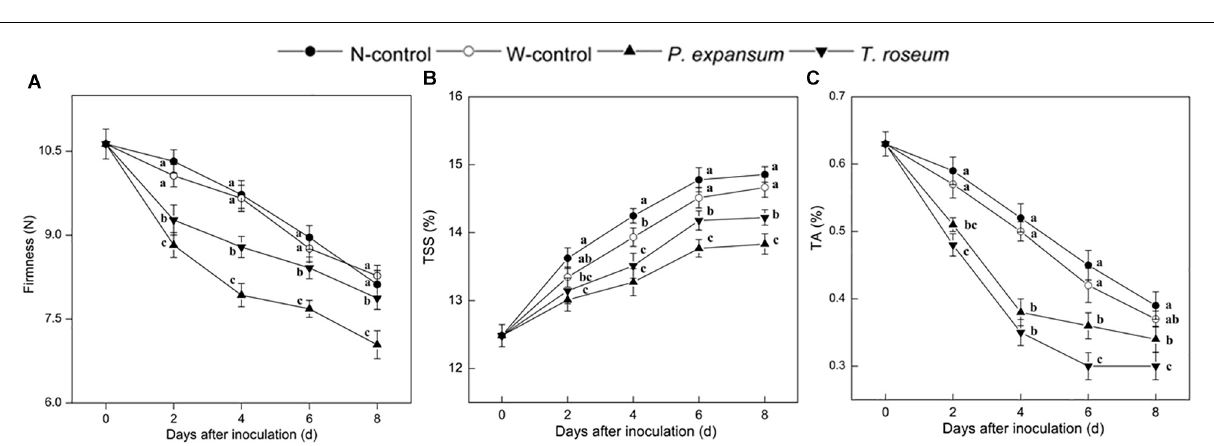
undecylenic acid and hexadecane were only identified in the T. roseum -inoculated ones. Nevertheless, both of inoculations had no significant effect on number of VOCs, but it affected the concentration range of VOCs. The P. expansum -inoculated